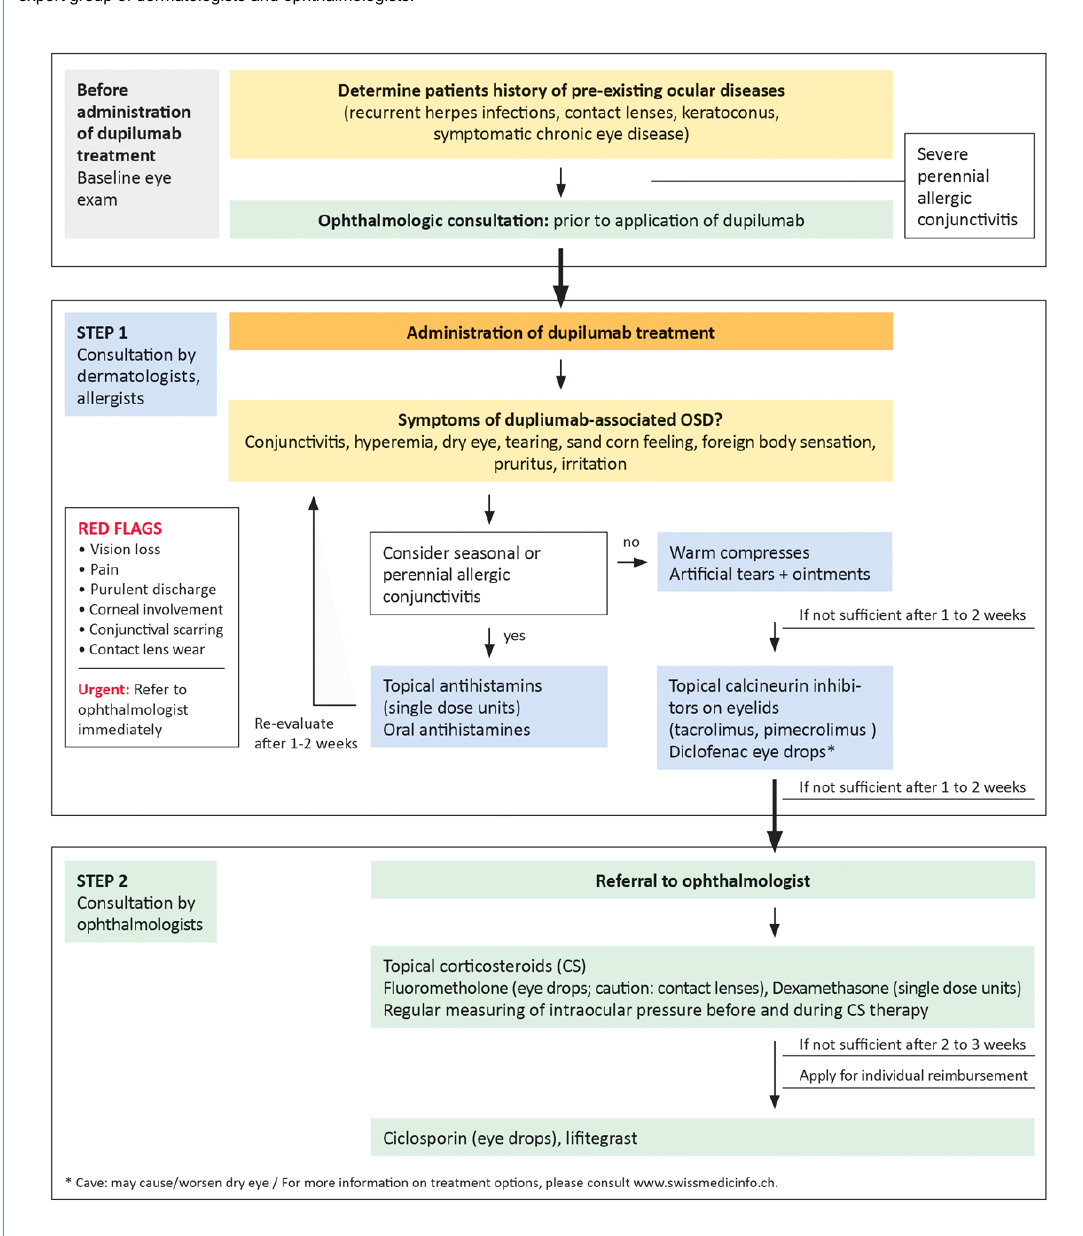
Figure 3: Algorithm for the management of dupilumab-associated ocular surface diseases in atopic dermatitis patients developed by a Swiss expert group of dermatologists and